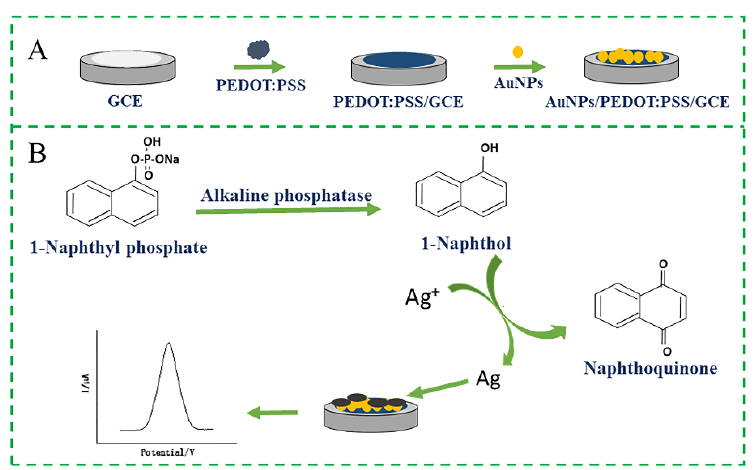
Scheme 1. Schematic of the sensing strategy for ALP detection: ( A ) the preparation of the electro- chemical electrode with PEDOT:PSS and AuNPs; ( B ) the electrochemical detection principle of